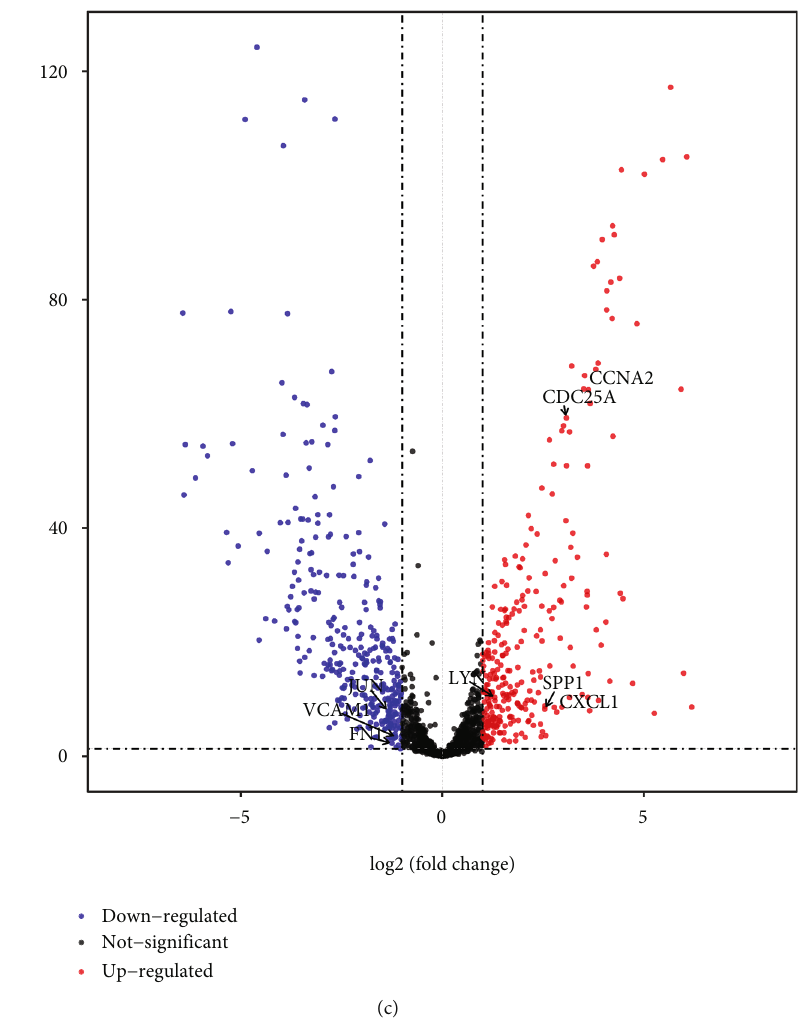
Figure 4: Construction of the eight-ARG prognostic signature. (a) Forest map of ARGs with P < 0.2 in Cox regression analysis. Genes and corresponding P and HR values are on the left; the red square on the right indicates HR > 1, the green square indicates the HR < 1, and the line segments on both sides of the square are 95% CI for HR. (b) Forest map of ARGs obtained by a step multivariable Cox regression analysis. (c) Volcano plot shows the distribution of prognostic genes in